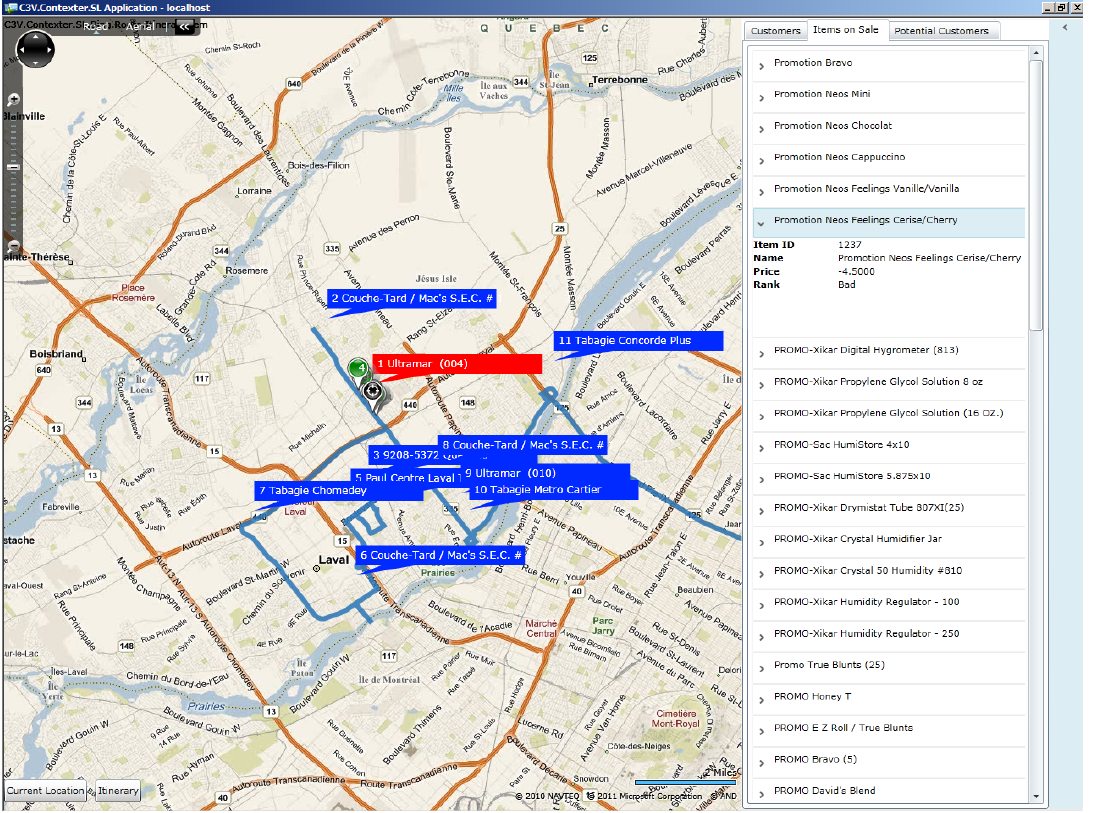
Figure 13. Silverlight